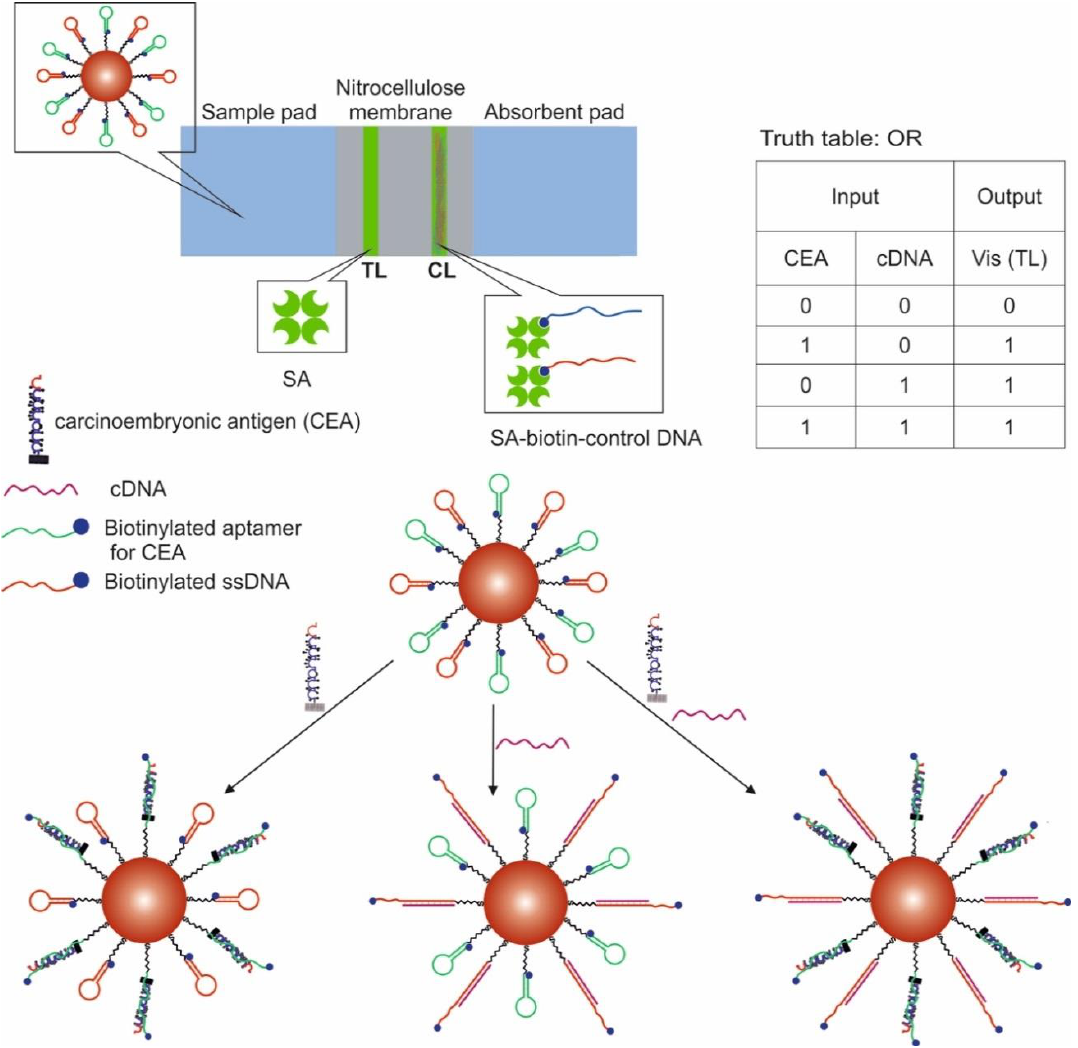
Figure 6. The OR logic gate. Adapted from Reference [68]. Copyright © 2020 Elsevier B.V.